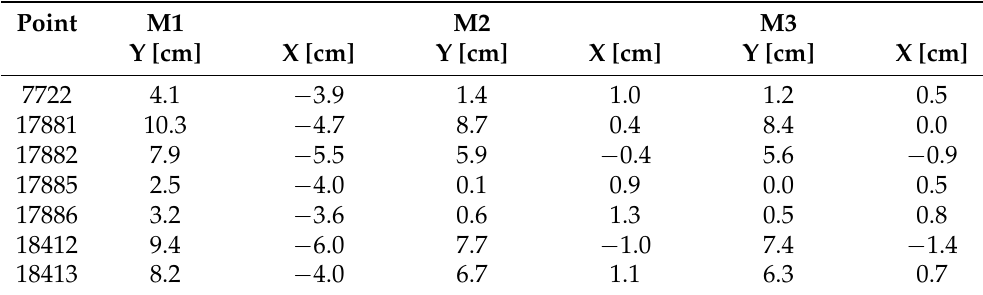
Figure 5. Distortion of the control points in Gramastetten. The red arrows show the direction and amount of distortion (data: BEV). Table 4. Results of the different methods using the two originally used control points: M1 (local transformation by 2D Helmert transformation), M2 (IDW based on residuals), and M3 (IDW based on homogeneous vectors).